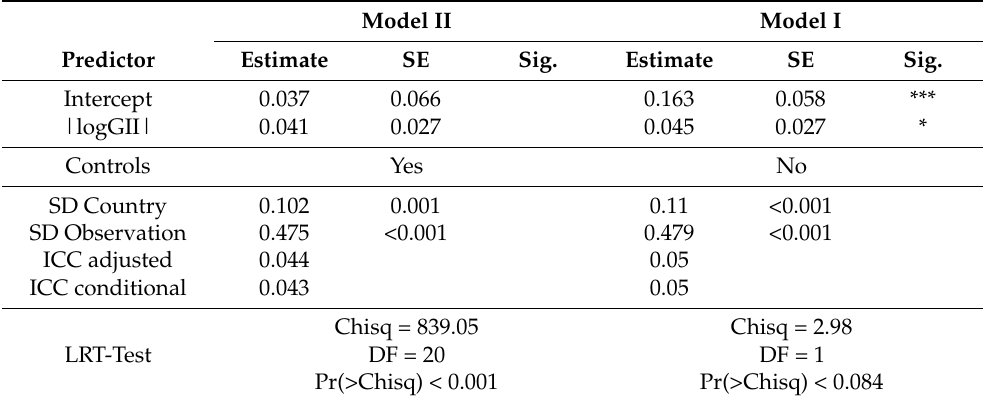
Table 6. Multilevel linear models of the effect of GII on SNI community